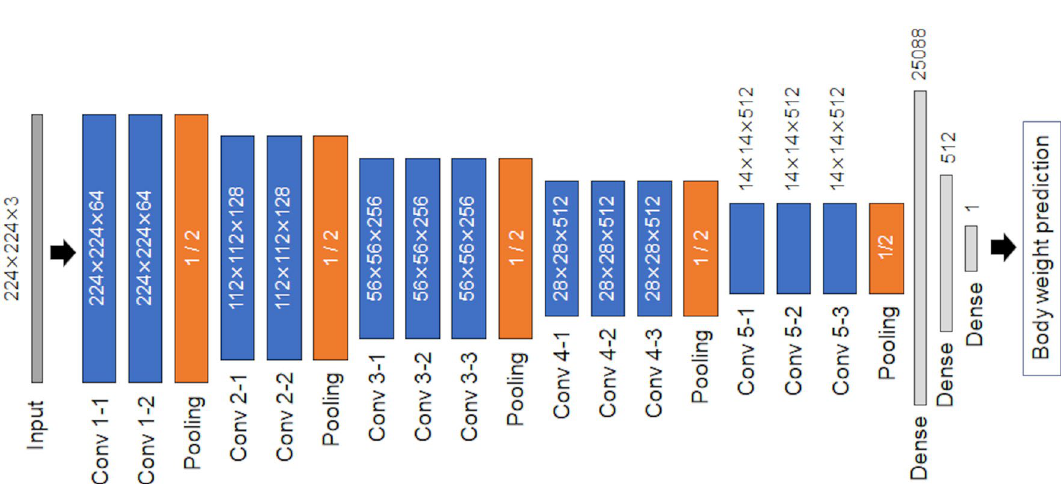
Figure 2. Convolutional neural network (CNN) architecture based on the VGG16 architecture. Only the fully connected layer of the original VGG16 was modified as output shape was fit to 1 for the regression